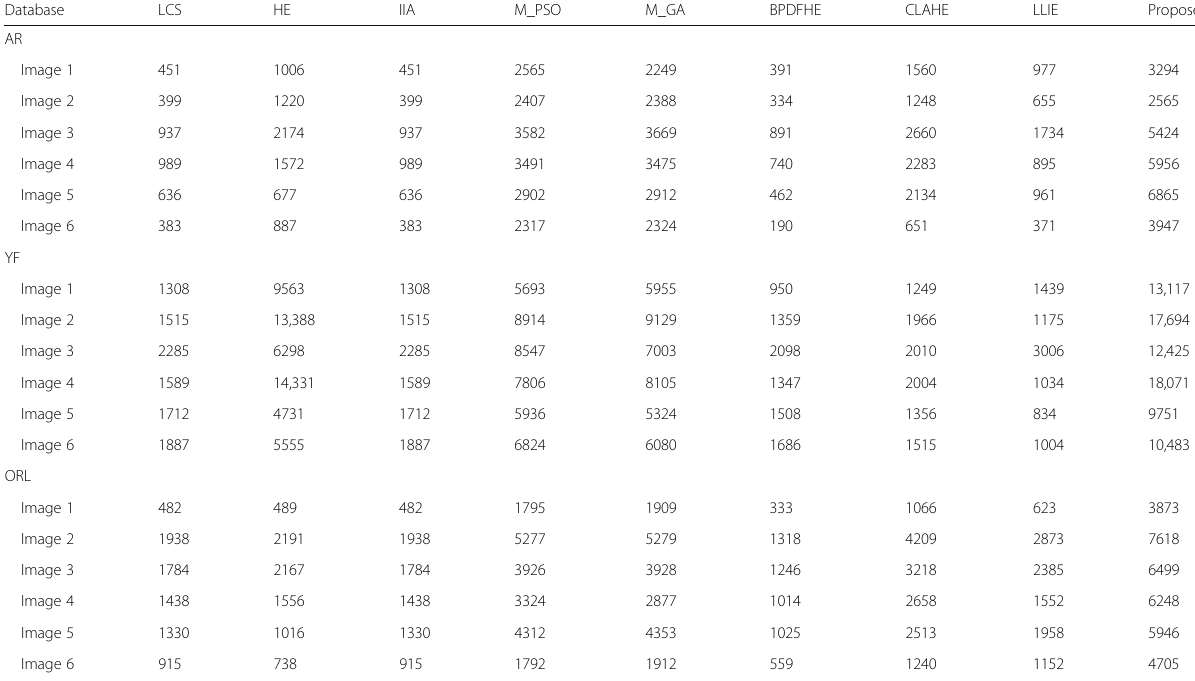
Table 4 Number of pixels in the foreground value comparison between results obtained using different enhancement methods on standard benchmark face datasets